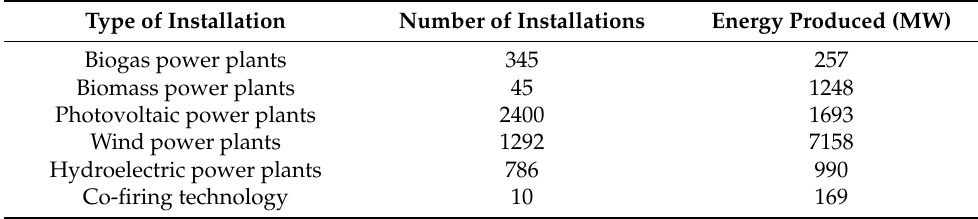
Table 1. Installations of renewable energy sources in Poland as of 31 December 2021.